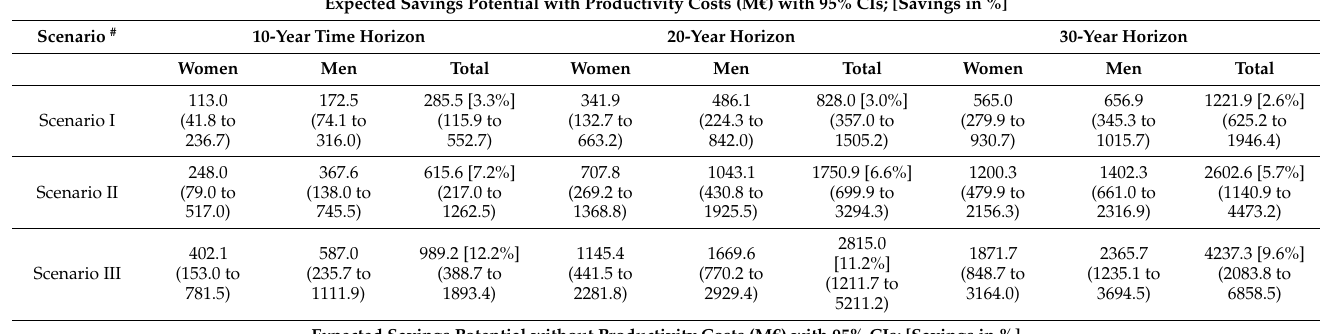
Table 4. Projected cumulative economic changes compared with the baseline situation in the year 2017 with and without productivity